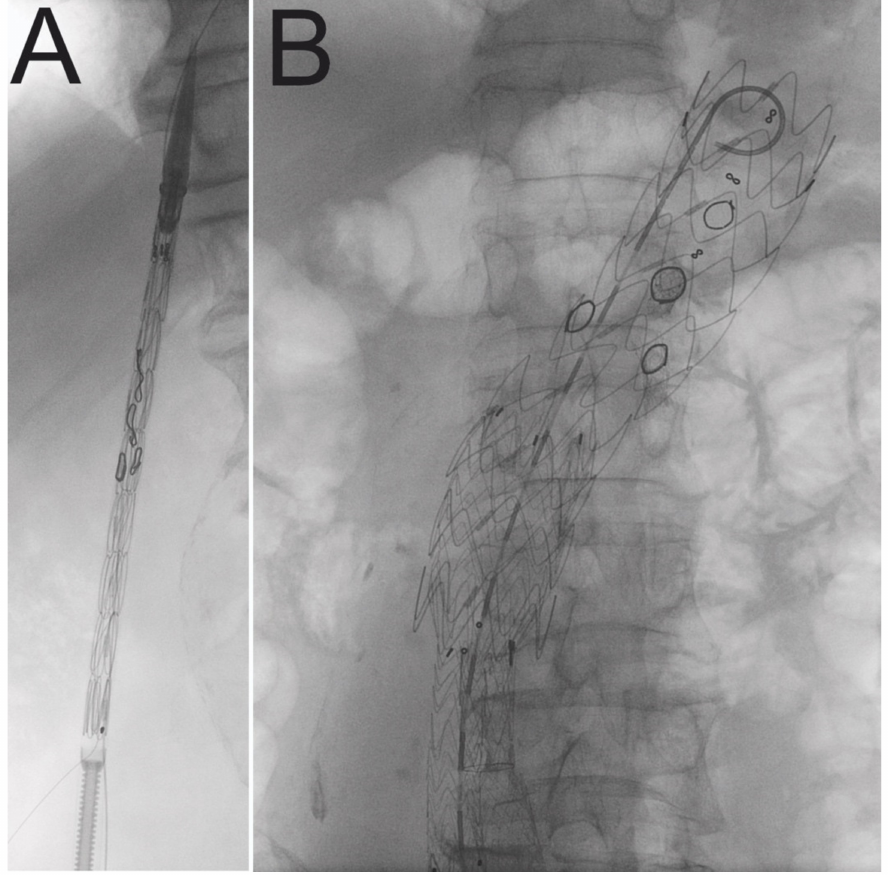
Figure 2. Fluoroscopy view of modified stent graft including radiopaque fenestrations markers. Stent graft before ( A ) and after ( B )